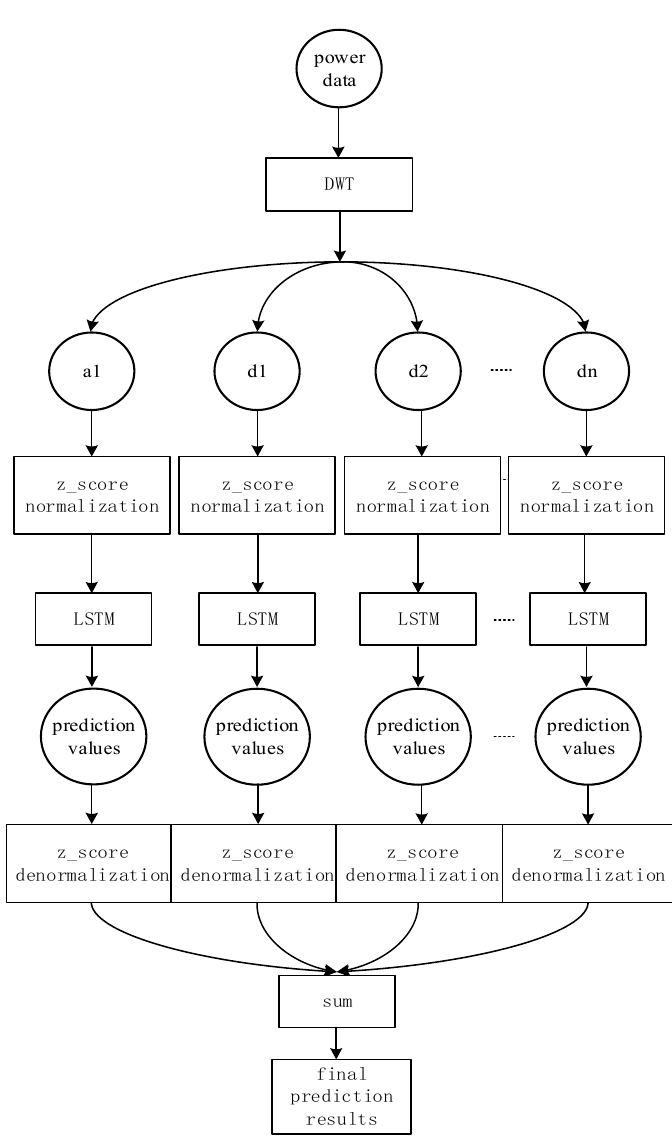
Figure 4. The forecasting process of the discrete wavelet transform and long short-term memory network (DWT_LSTM).